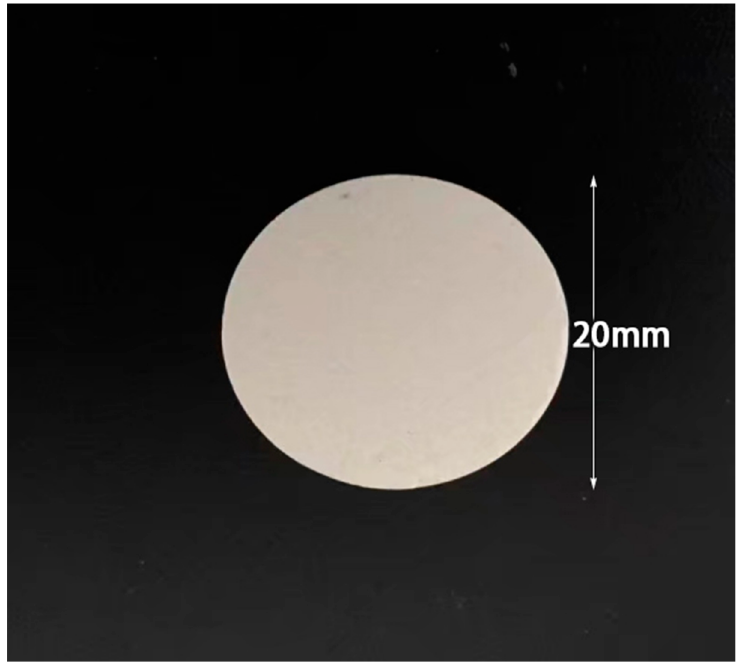
Figure 6. Optical photo of the monolithic leucite sample.